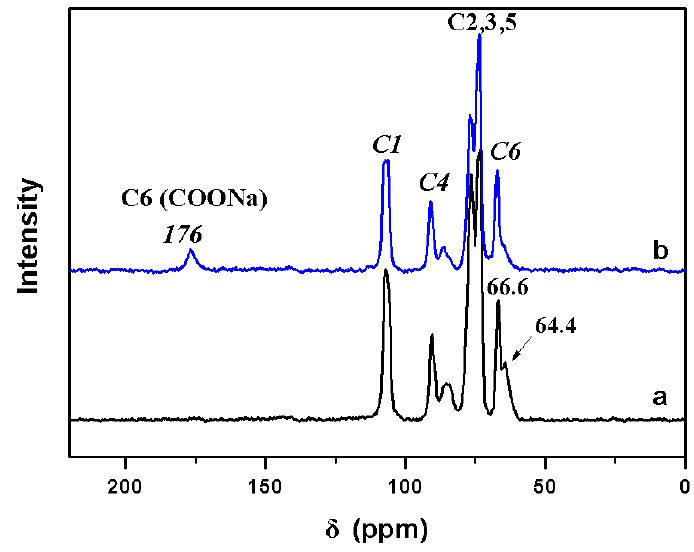
Figure 4. Solid-state 13 C-NMR spectra of the original cellulose ( a ) and cell-COONa ( b ).